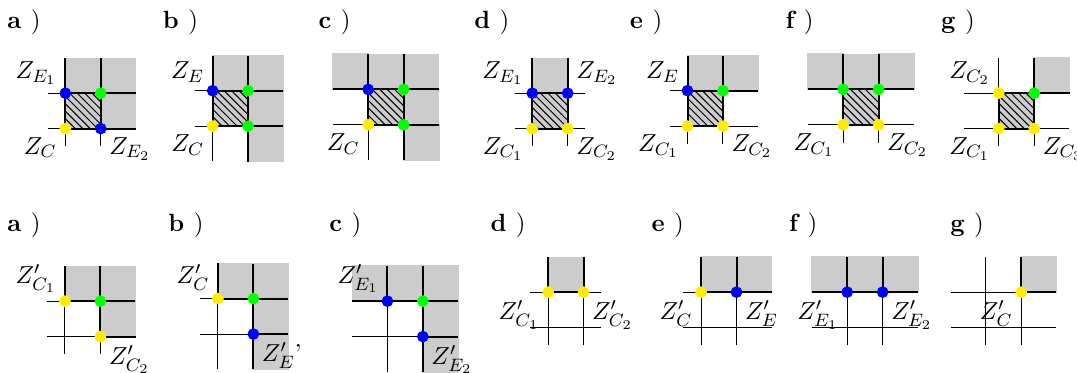
Figure 6. Reduction scheme applied to different cases. Top: different initial cases: corner boundary points (yellow), edge boundary points (blue), internal points (green). Edges belonging to X are thickened. Bottom: final cases obtained reducing cases in figure 6g. The edges belonging to X 0 (gray shaded region) are